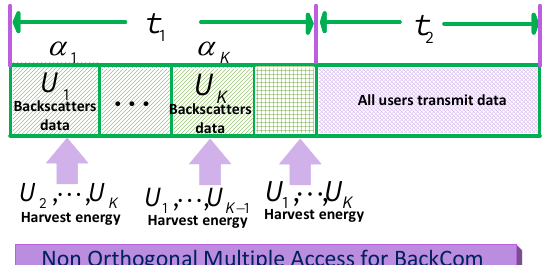
Figure 28. NOMA in